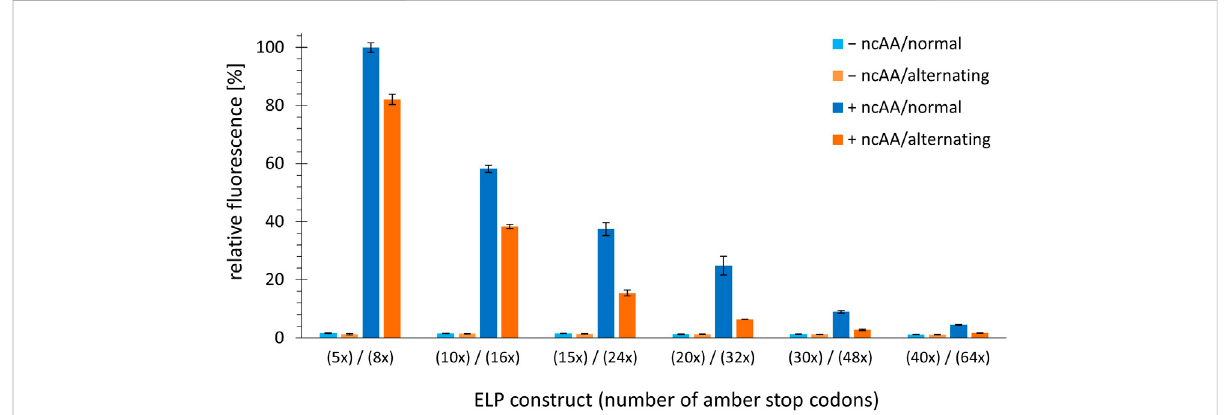
FIGURE 4 Comparison of OTS ef fi ciency upon alteration of the number and spacing pattern of in-frame stop codons. Ribosomal incorporation of m - o NB-Dopa (1 mM) into ELP-sfGFP constructs containing a varying number of in-frame amber stop codons. Constructs are shown as pairs of identical ELP fragment length (e.g. ELP(5x amber) and ELP(8x amber)). Normal = one amber stop codon per three VPGXG repeats, equidistant placement. Alternating = alternating amber stop codons, see Supplementary Material for sequence details. Intact cell fl uorescence of E.